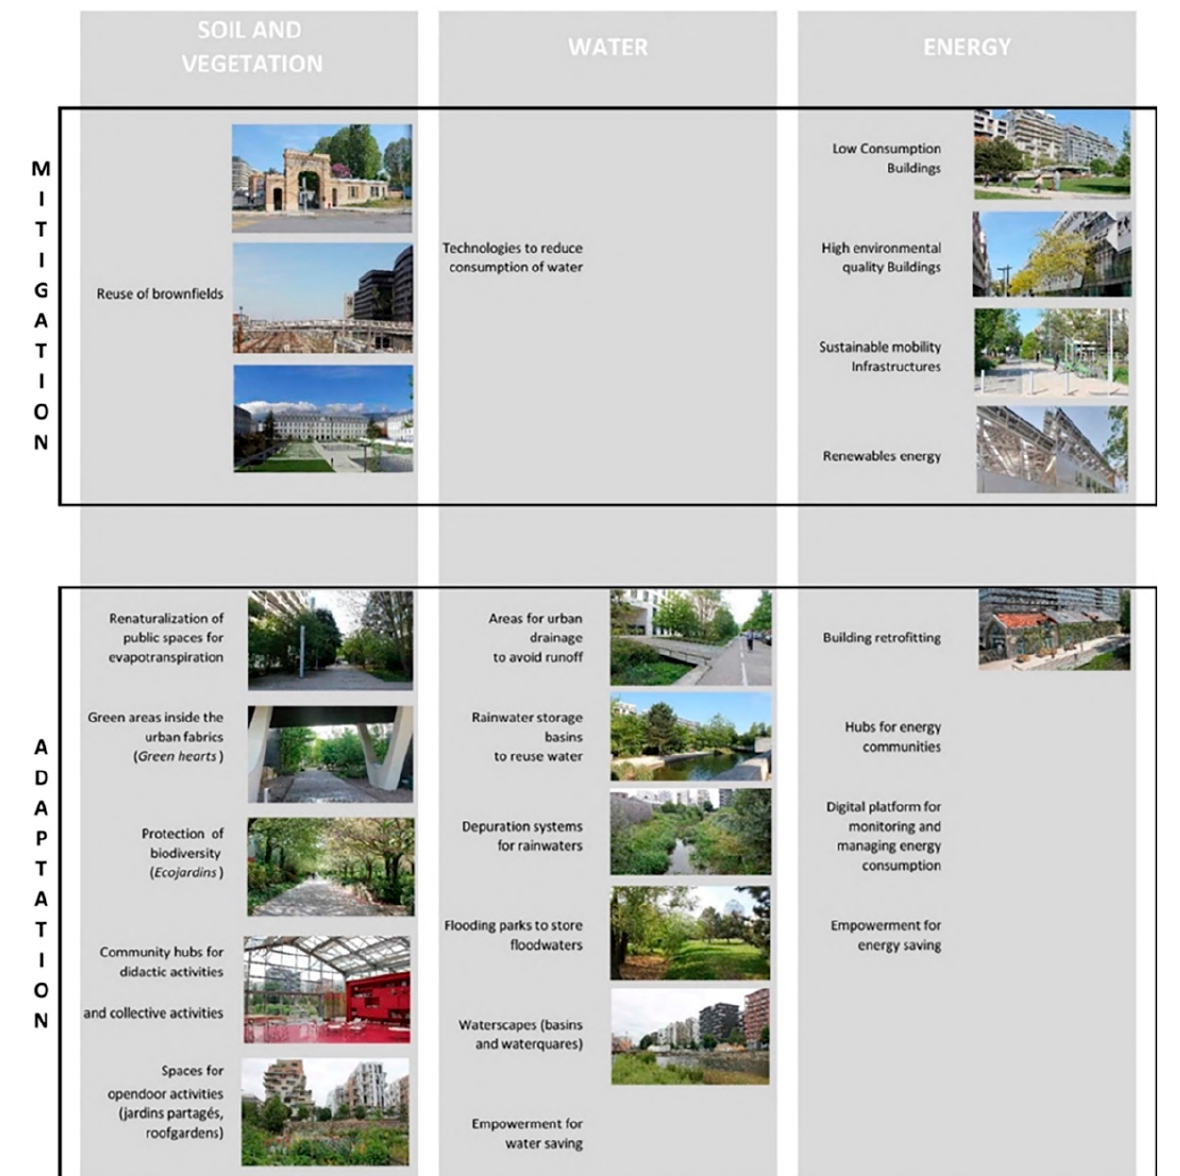
Figure 4. Synthetic abacus of the adaptation and mitigation measures within the 4 projects. Source: Authors’ elaboration (2022) from the analysis of the 4 case studies, data based on http://www.ecoquartiers.logement.gouv.fr (accessed on 19 June 2022) and on survey/onsite visit (accessed on 19 June 2022).